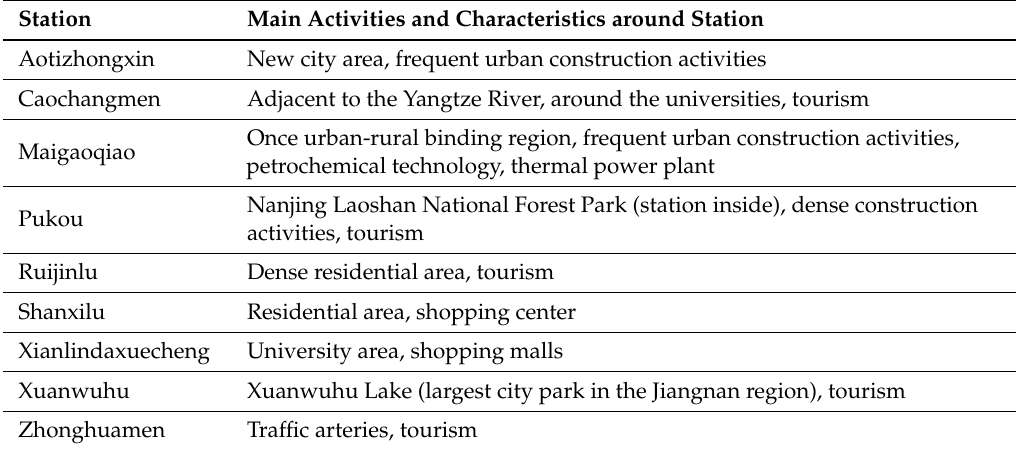
Table 2. The typical characteristics for each particulate matter (PM) monitoring station in Nanjing city.